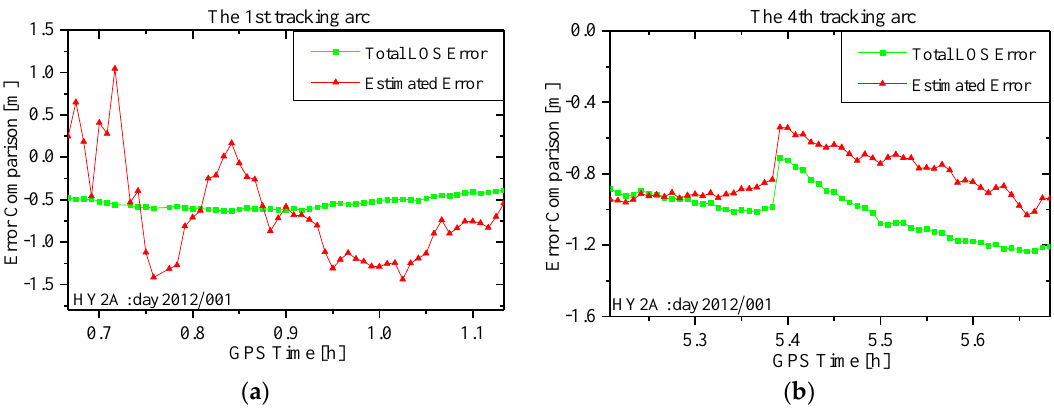
Figure 11. Comparison of LOS errors in a tracking arc. ( a ) The first tracking arc of Figure 8; and ( b ) the